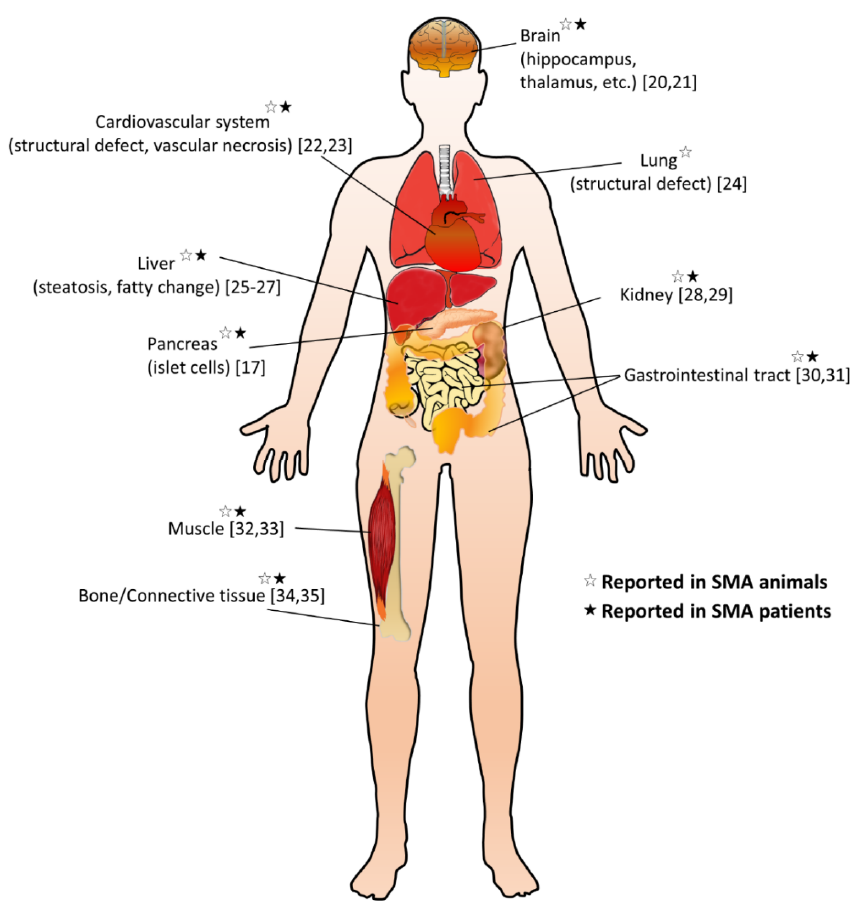
Figure 1. Overview of non-neuromuscular systemic pathology in spinal muscular atrophy (SMA). A summary of multi-organ involvement has been reported in SMA animal models and/or patients